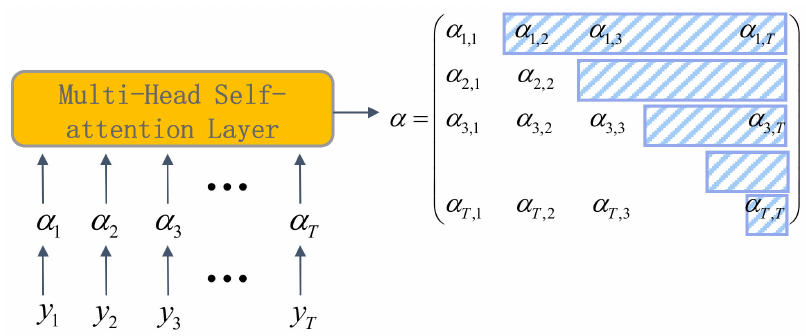
Figure 7. Masking